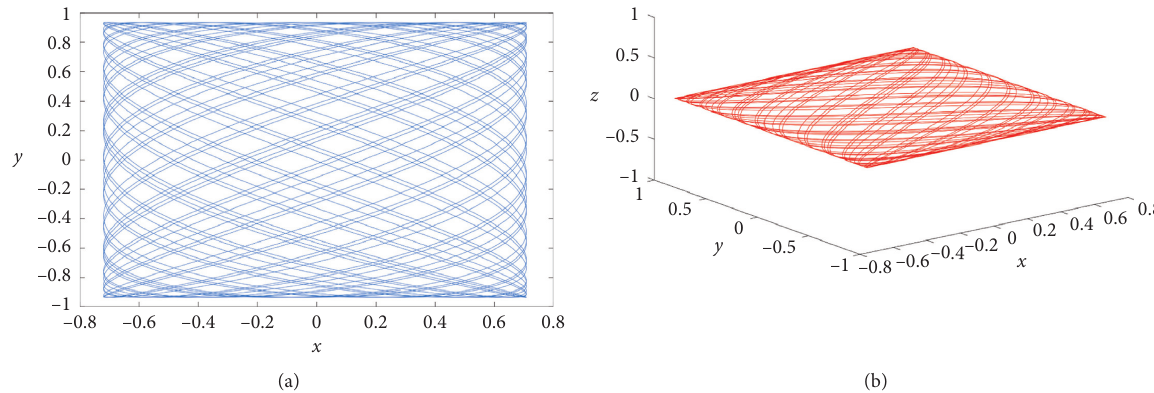
Figure 4: Quasiperiodic orbit of Lissajous type in the (a) x-y plane and (b) x-y-z space, respectively, when μ � 0 .